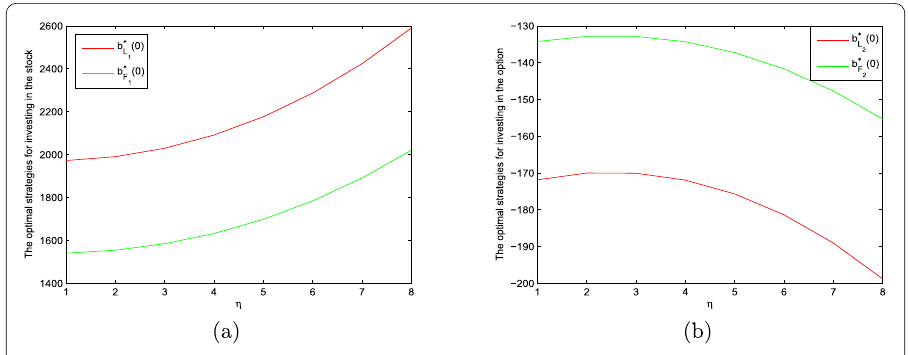
Figure 3 Sensitivities of optimal investment strategies to parameter η